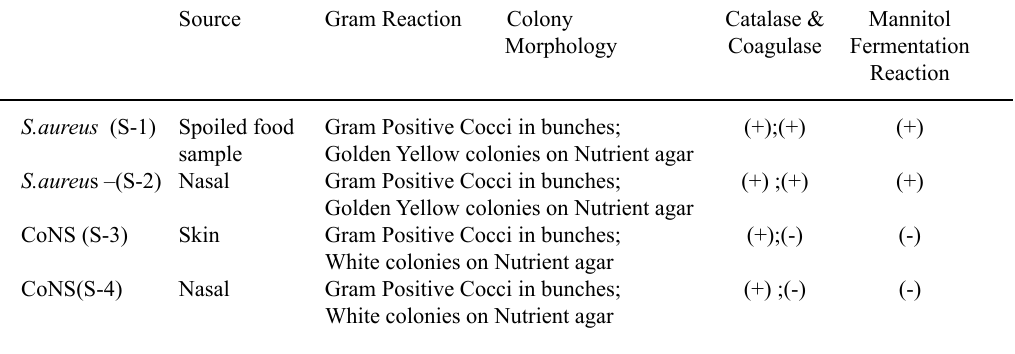
Table 2. Results of storage effect of breast